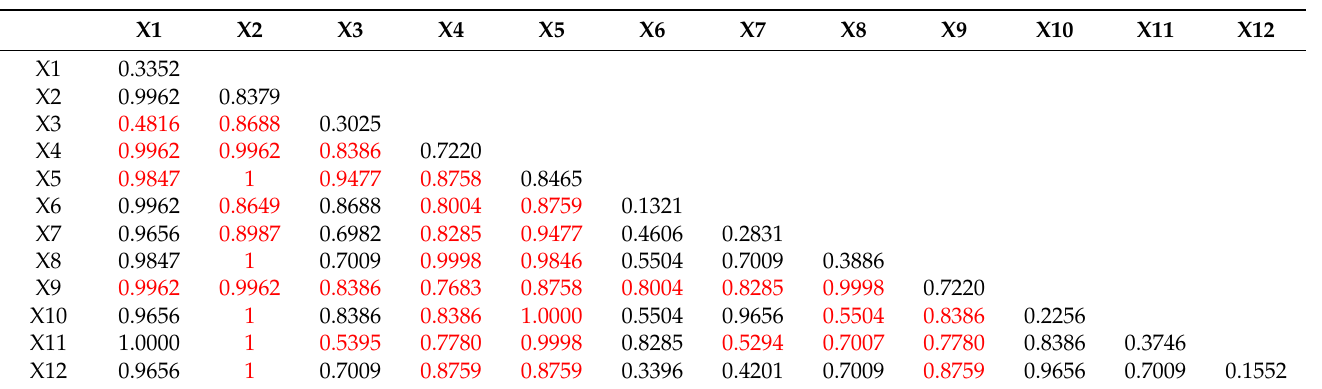
Table 2. Results of factor interaction analysis.